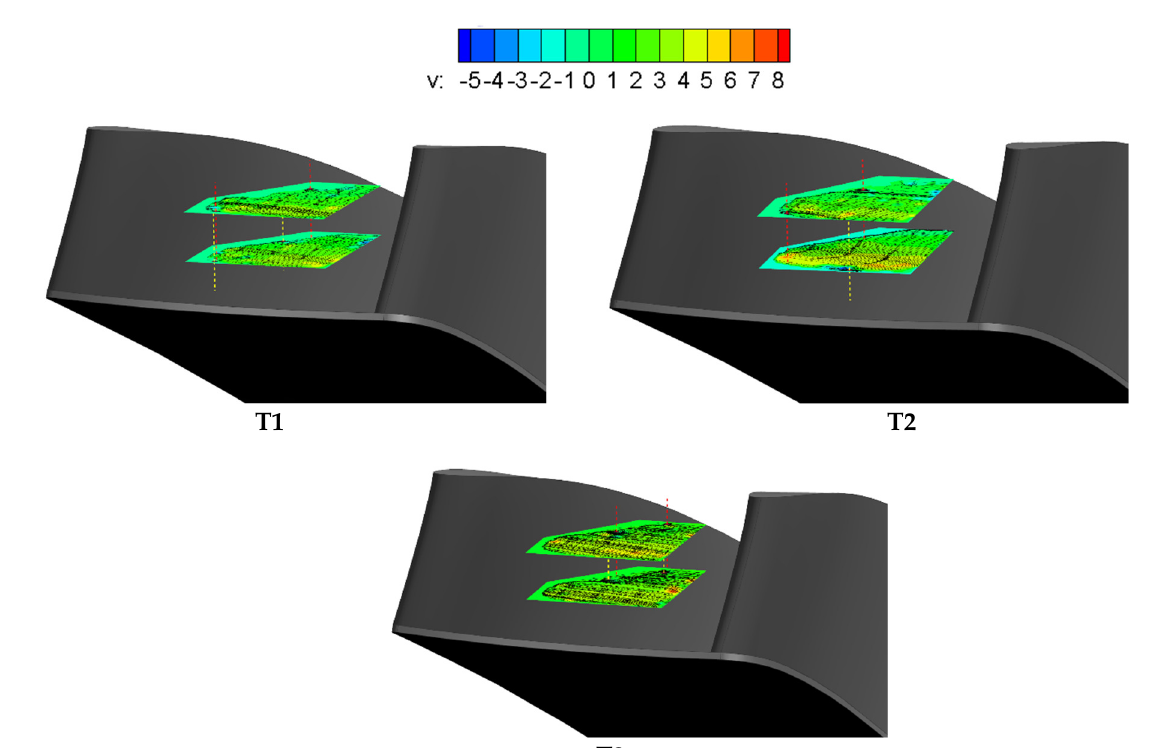
Figure 14. Incipient vortex conditions at high unit speeds. T1–T3 is the moment of shooting.